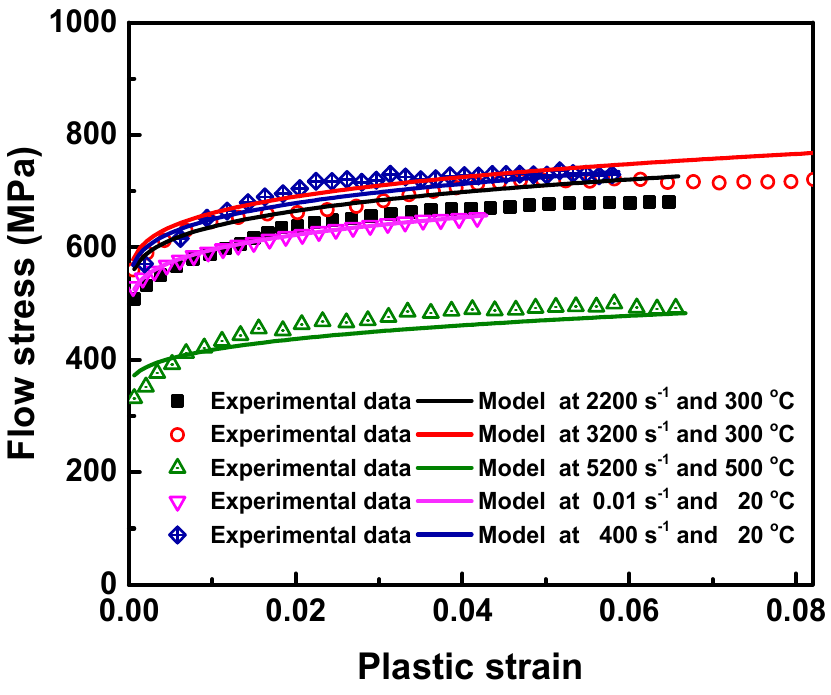
Figure 6. Comparison of the experimental data and prediction results of the identified model through multi-objective strategy.